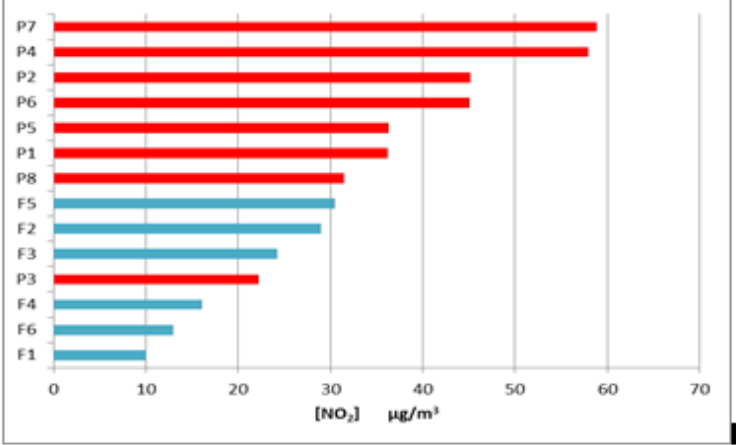
Figure 5. Increasing distribution of sites by NO 2 concentration.